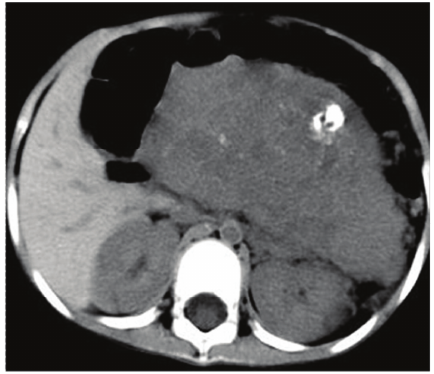
Figure 3: Axial unenhanced abdominopelvic CT showed a large, solid, and heterogeneous mass with scattered